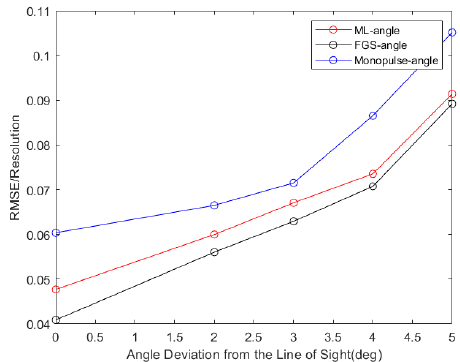
Figure 7. Statistical performance results versus angle deviation from the line of sight.